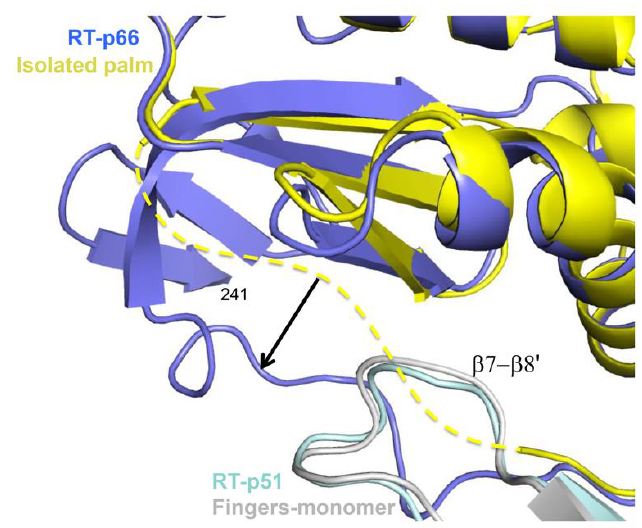
Figure 9. Formation of the palm:fingers’ interface. Superposition of the inter-subunit